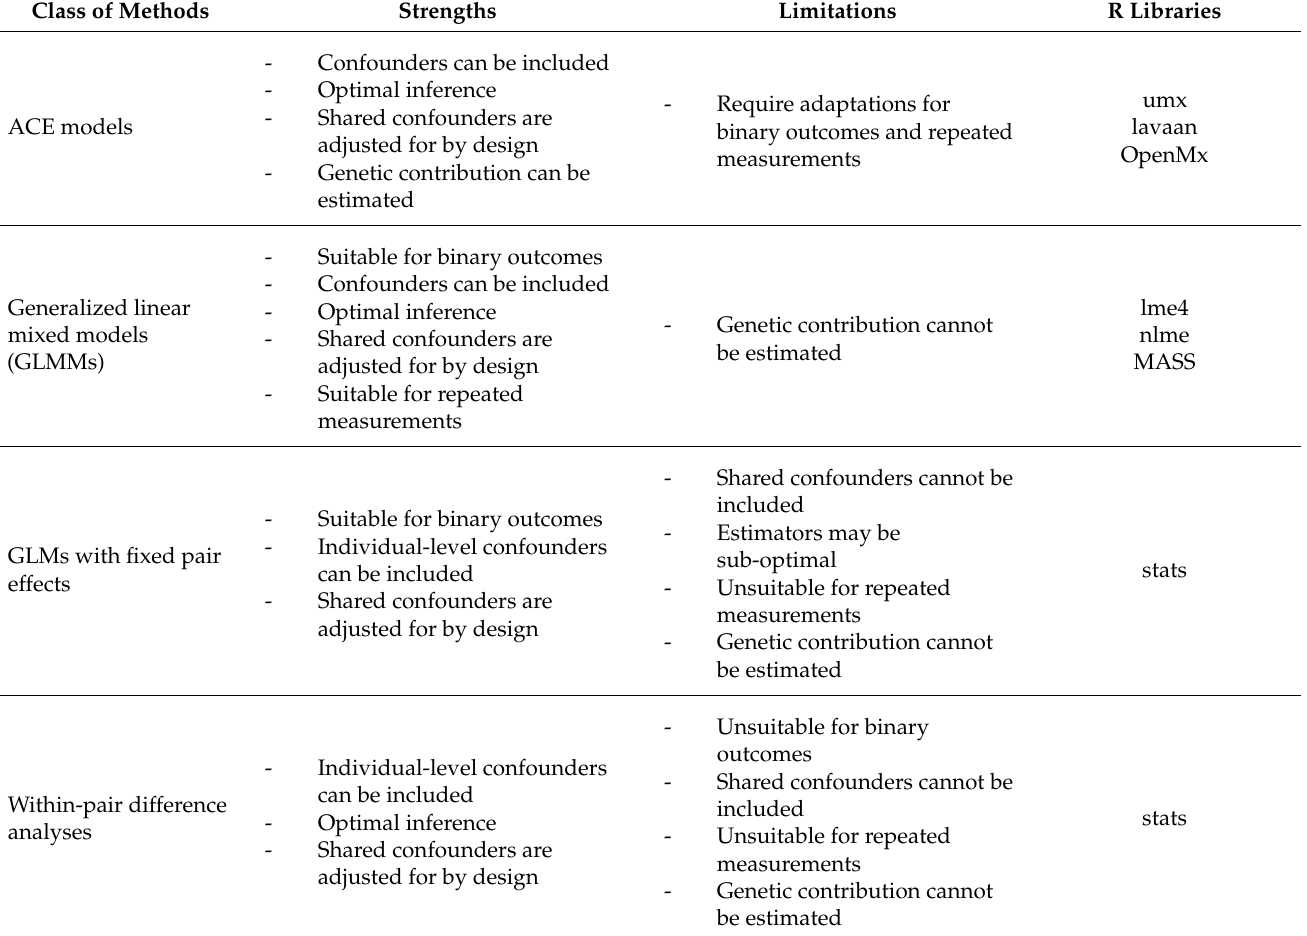
Table 1. Classes of statistical methods used in the reviewed